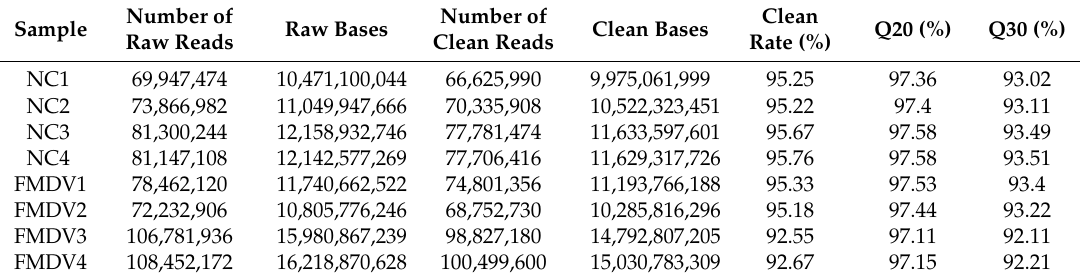
Table 1. Results of data filtering statistics.